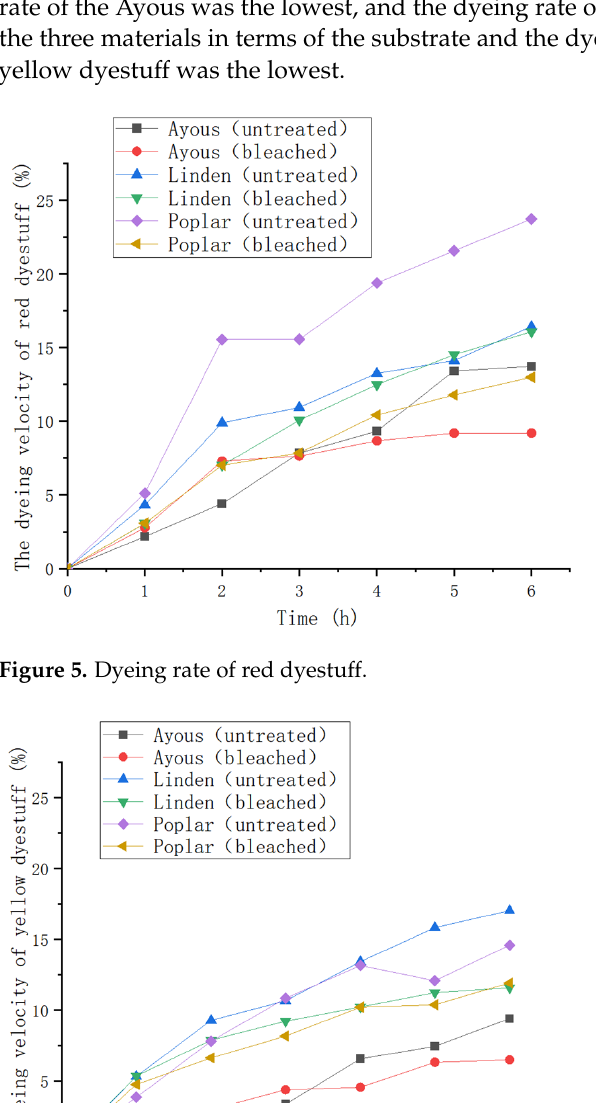
Figure 7. Dyeing rate of blue dyestuff. The final dyeing rates of the red and blue Linden veneer tended to be similar to the untreated dyed veneers, while the final dyeing rates of the other veneers were less than those of the untreated dyed veneers. The final dyeing velocities of the red and yellow Ayous veneers, yellow Linden veneer, and red, yellow, and blue Poplar veneers decreased by 4.54%, 2.91%, 5.45%, 10.75%, 2.66%, and 9.55%, respectively. This indicates that the dye adsorption capacity of the untreated veneers was higher than that of the dyed veneers with the bleach pretreatment. The bleach pretreatment damaged the wood structure to some extent, and the wood degraded, such that the dye molecules could attach better, resulting in a generally lower final staining rate for the bleached veneers than that of the untreated veneers. The final staining velocities of the dyed veneers were slightly higher than that of the bleach-pretreated dyed veneers. Therefore, there is a correlation between the staining rate of the wood and the species, the dye, the staining time, and the bleach pretreatment. 3.3. Micro-Analysis Bleach treatment is a pretreatment process for wood dyeing. By degrading the color- forming groups in the lignin and removing the extractives of the surface, it opens up the